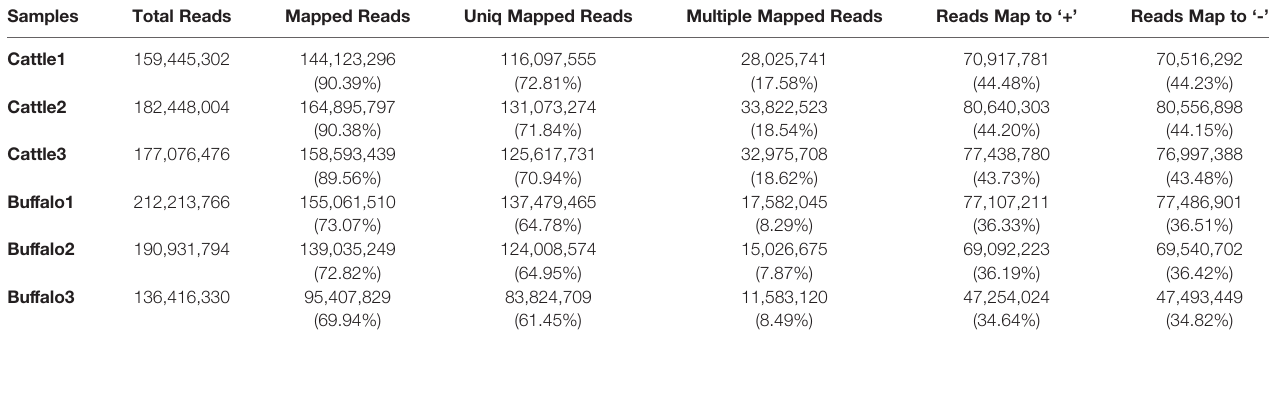
TABLE 4 | Summary of reads mapping to the reference genome. Samples